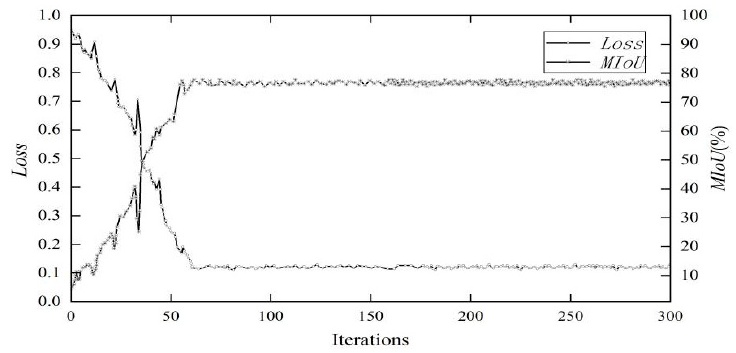
Figure 6. The iteration loss and MIoU of the U-type network.